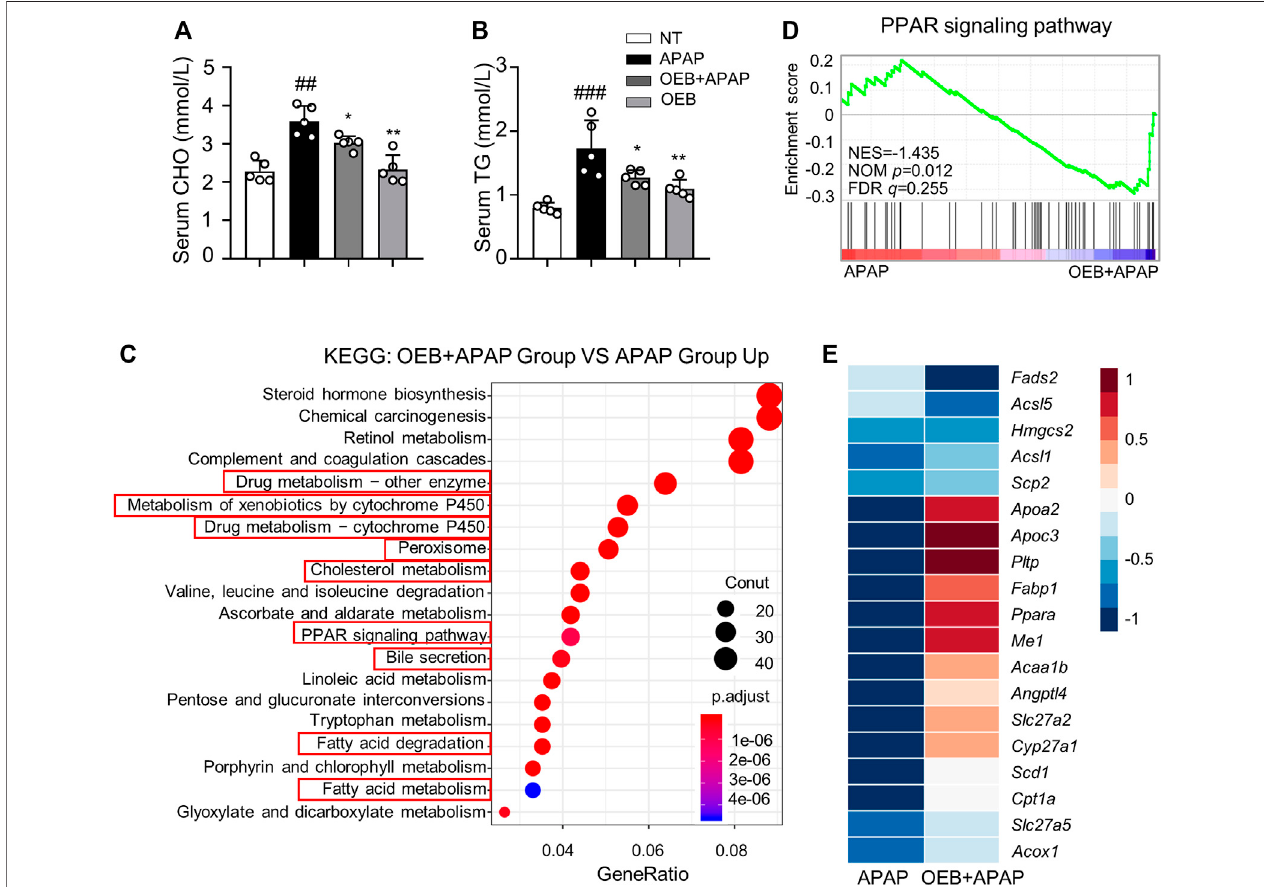
FIGURE 6 | RNA-Seq analyses revealed signi fi cant difference in PPAR lipid metabolism between the presence or absence OEB pretreated in the APAP treated groups. Hepatotoxicity was analyzed by measuring serum (A) CHO and (B) TG levels ( n = 5). (C) KEGG pathway enrichment analyses of the OEB + APAP ( n = 3) and APAP ( n = 3) groups. (D) GSEA pathway enrichment analysis of pathways related to PPAR signaling pathway. (E) Heatmap of PPAR-related gene expression pro fi les based on the GSEA results. * p < 0.05, ** p < 0.01 versus APAP-treated group. ## p < 0.01, ### p < 0.001 versus NT group.